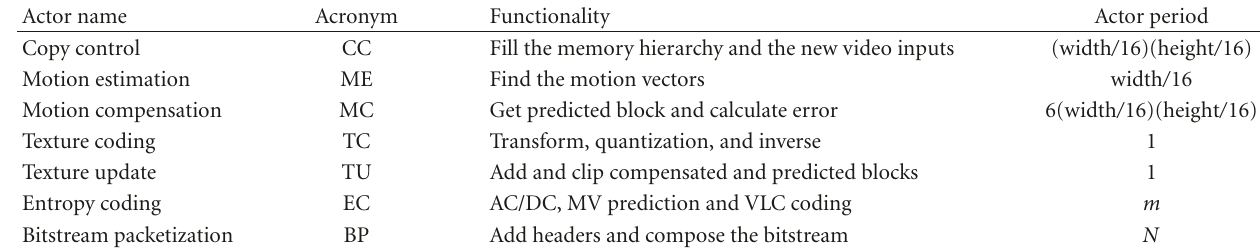
Table 1: Detailed information of the actors in the encoder CSDF graph.